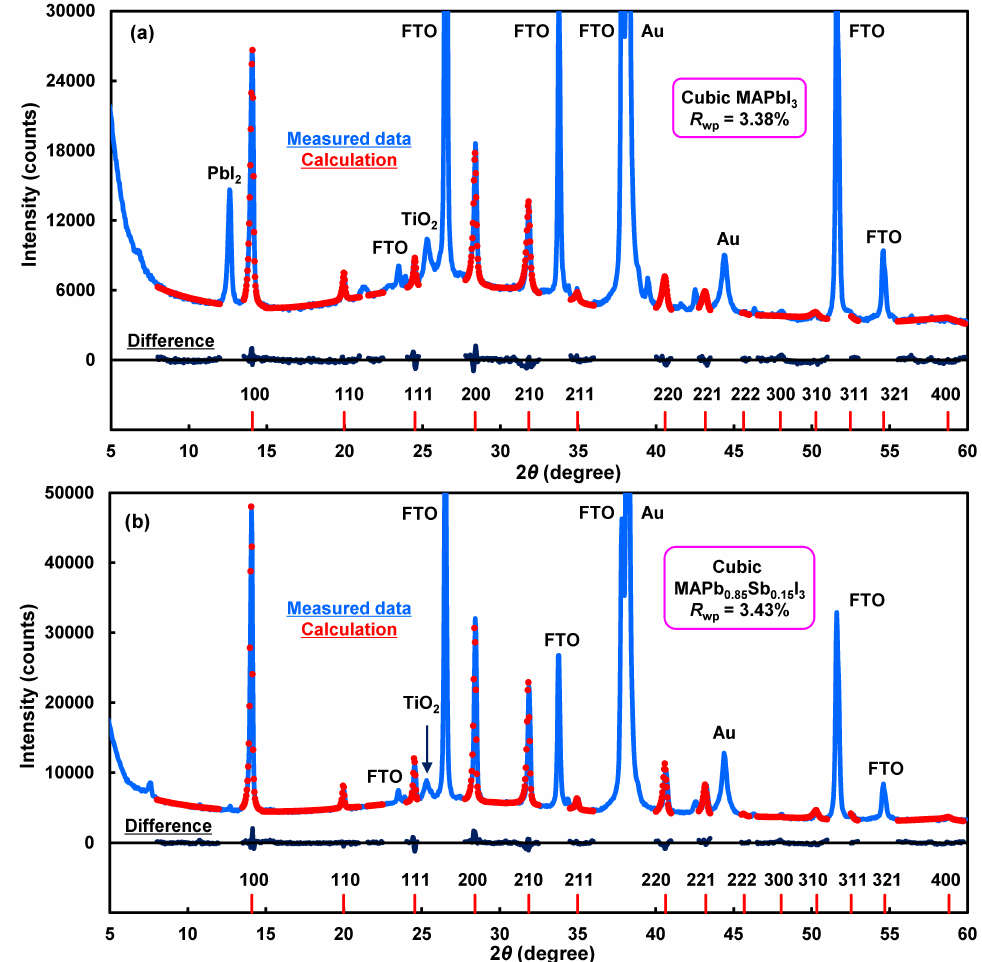
Figure 43: Measured (solid) and optimized (dotted) X-ray diffraction profiles for the (a) CH 3 NH 3 PbI 3 and (b) CH 3 NH 3 Pb 0.85 Sb 0.15 I 3 solar